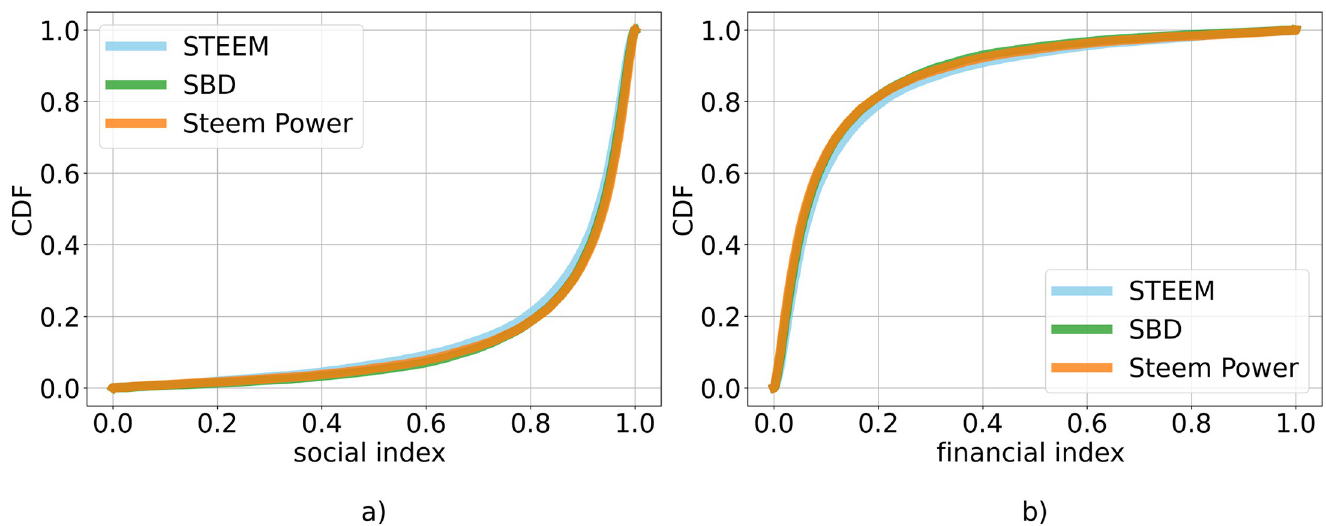
Fig 10. Social and financial indexes distribution. Cumulative Distribution Function—CDF—of a) social _ index and b) financial _ index , for each currency. On the x- axis: social _ index and financial _ index , that measure whether a user relies more on social or financial actions, respectively. On y-axis: CDF.